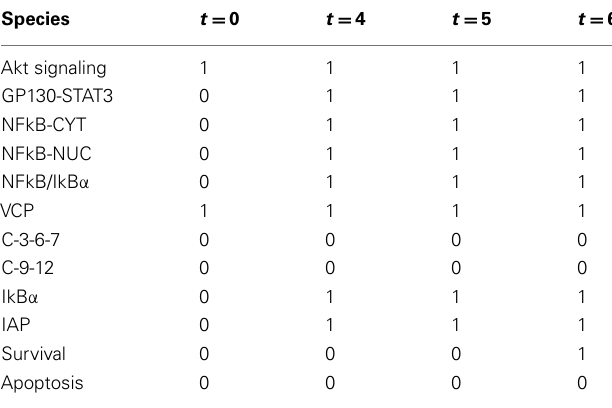
Table includes simulation results of humanized yeast apoptosis model by inser- tion ofVCP.T stands for different time steps.VCP in presence of Akt Signaling is expected to prevent apoptosis and promote survival at last time